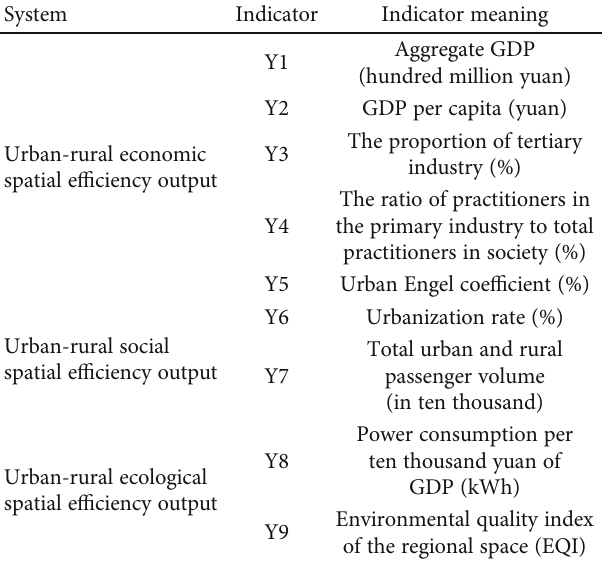
Table 2: Indicators of the urban-rural spatial e ffi ciency output system.